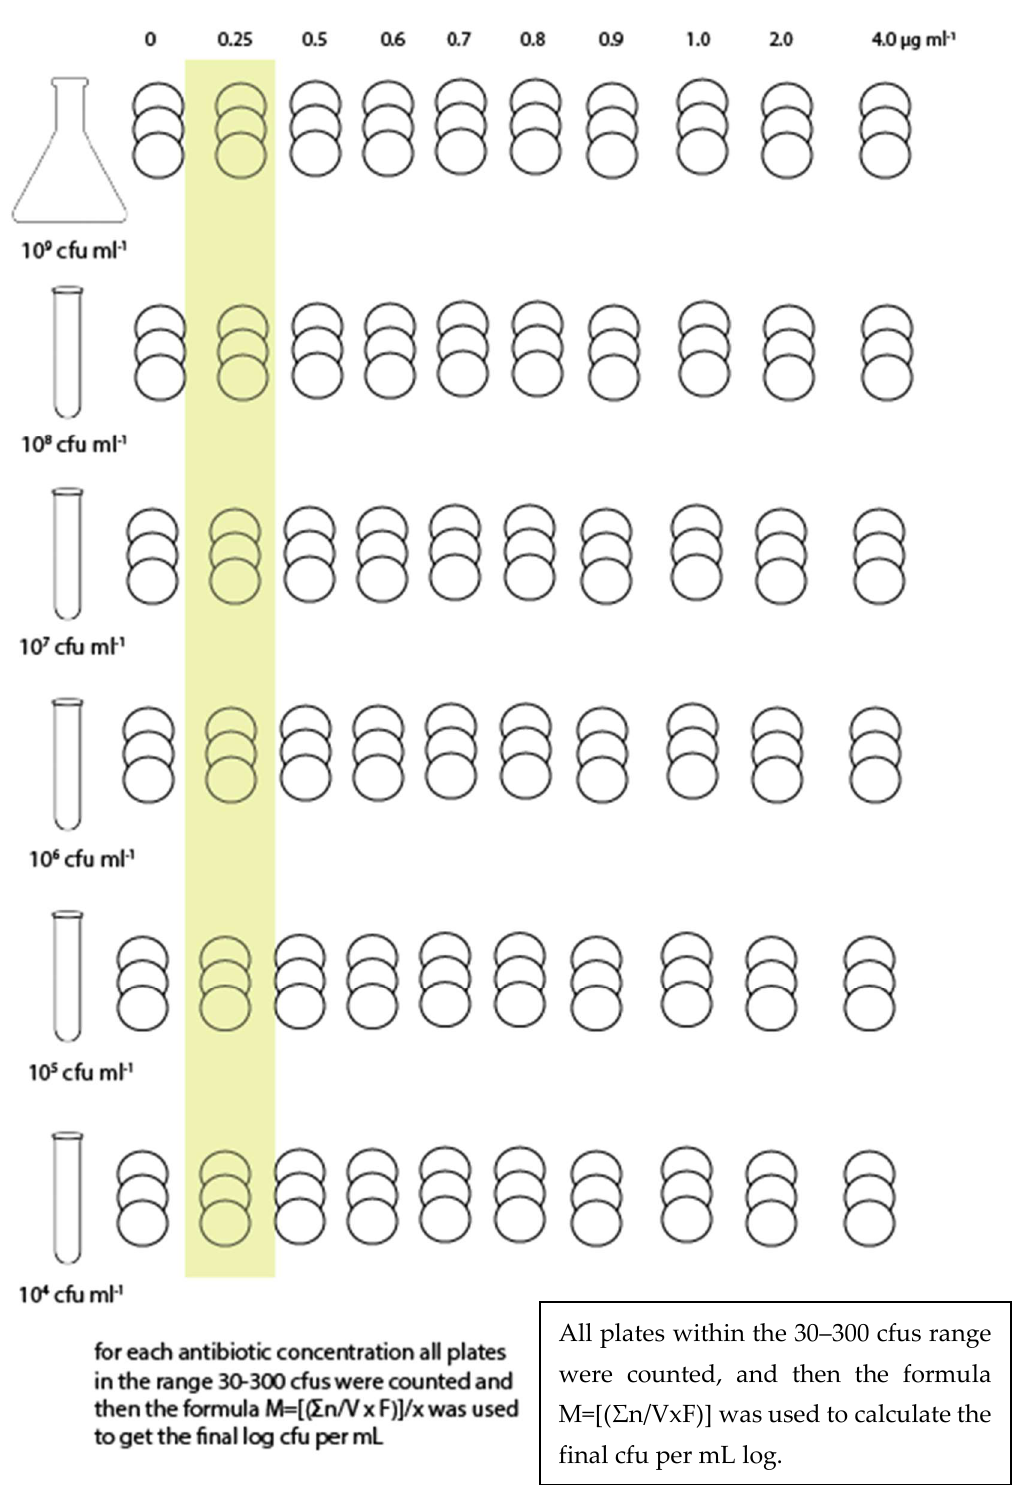
Figure 2. Sampling scheme for Barnes agar.